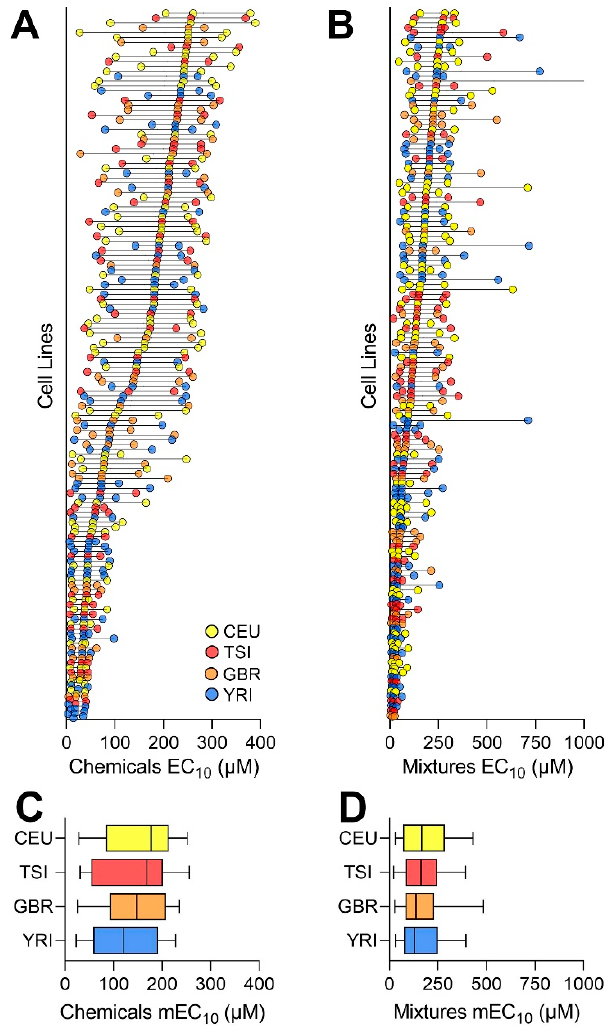
Figure 4. Cell-line specific distribution of chemical and mixture PODs. Distribution of the PODs (EC 10 values) for all chemicals ( A ) and mixtures ( B ) arranged by each cell line’s median value. Colors represent the subpopulations (see inset). Each line is the inter-quartile range of the PODs, with the middle dot representing the median value. Overall distribution of median POD values for chemicals ( C ) and mixtures ( D ) across each subpopulation. Box-and-whisker plots show the interquartile range (boxes) and the 10th and 90th percentile (whiskers) of the distribution for each of the four subpopulations (colors are identical to those in panel ( A )).